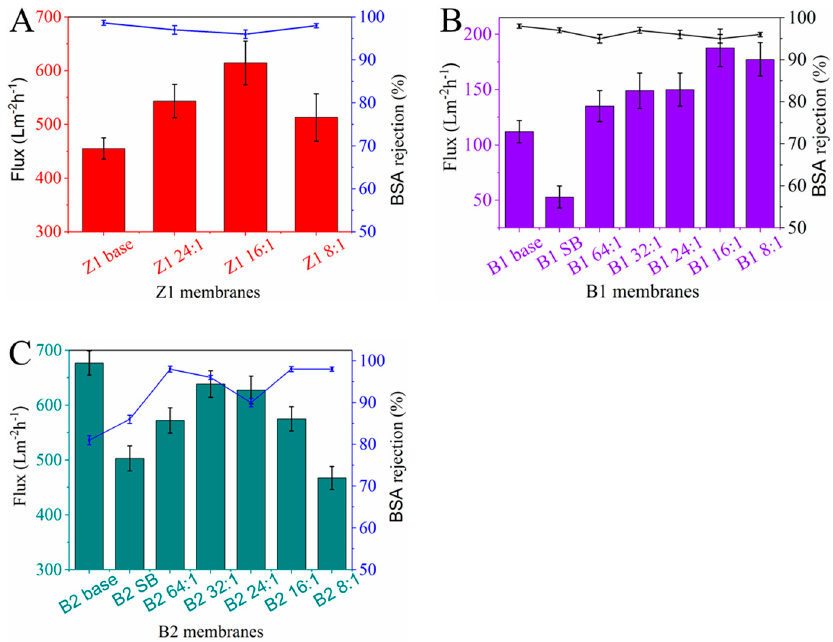
Figure 9. Pure water flux and BSA rejection of ( A ) Z1, ( B ) B1, and ( C ) B2 membranes at a pressure of 0.1 MPa.